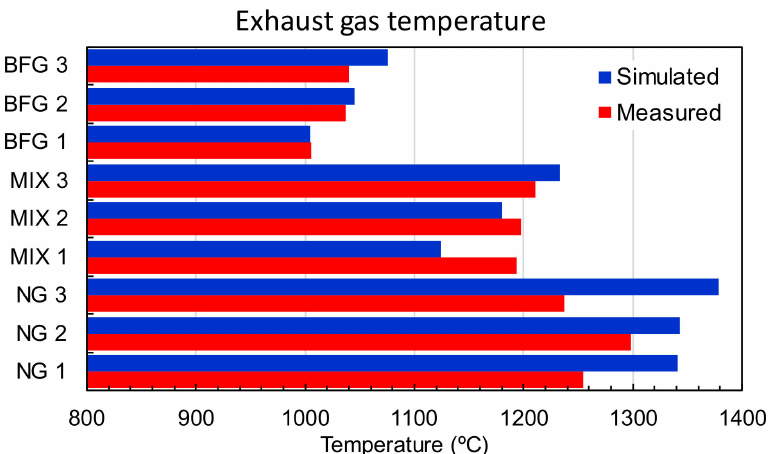
Figure 7. Comparison of exhaust temperatures measured and simulated.